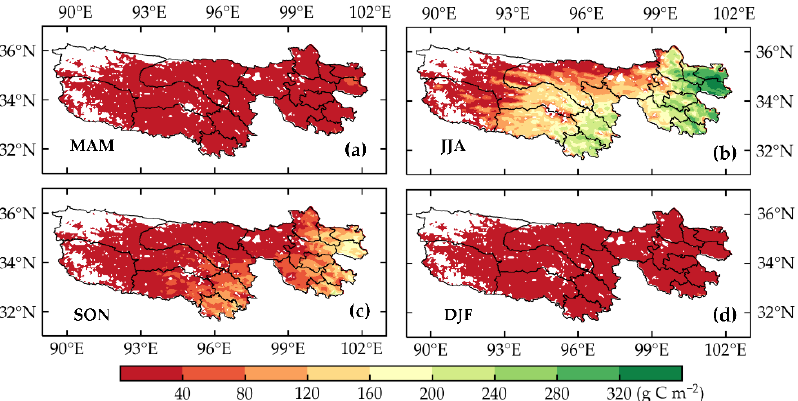
Figure 8. Multiyear seasonal spatial patterns of grassland AGB in the TRHR. ( a ) MAM (March, April, and May); ( b ) JJA (June, July, and August); ( c ) SON (September, October, and November); ( d ) DJF (December, January, and February).